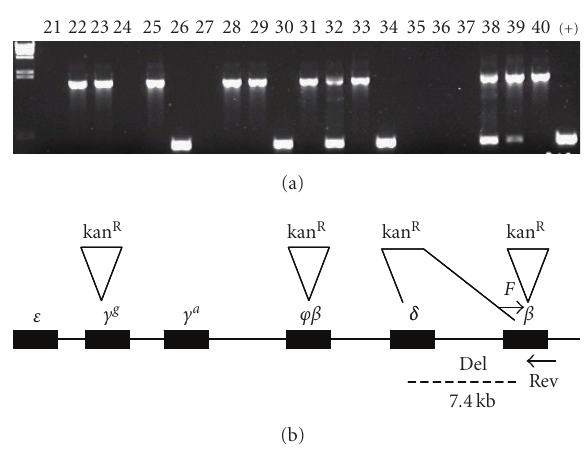
Figure 1: PCR colony screening of kan R recombinant clones. (a) The upper band, 1.7 Kb in length (lanes 3, 6, 8, etc.), corresponds to the larger PCR product after insertion of recombination cassette into β -globin gene. 11 clones reveal lower wild-type band, 440 bp in length (lanes 5, 9, 10, etc.) as a result of recombination into other duplicated regions of the globin locus ( γ g and ϕβ ). No PCR product (11 clones) is due to the δ - β deletion of the F primer binding site. Lanes 32,38 with double bands represent the colonies with heterogeneous BAC population within single colony. (b) Diagram of globin locus illustrating insertion of kan R cassette at four di ff erent globin